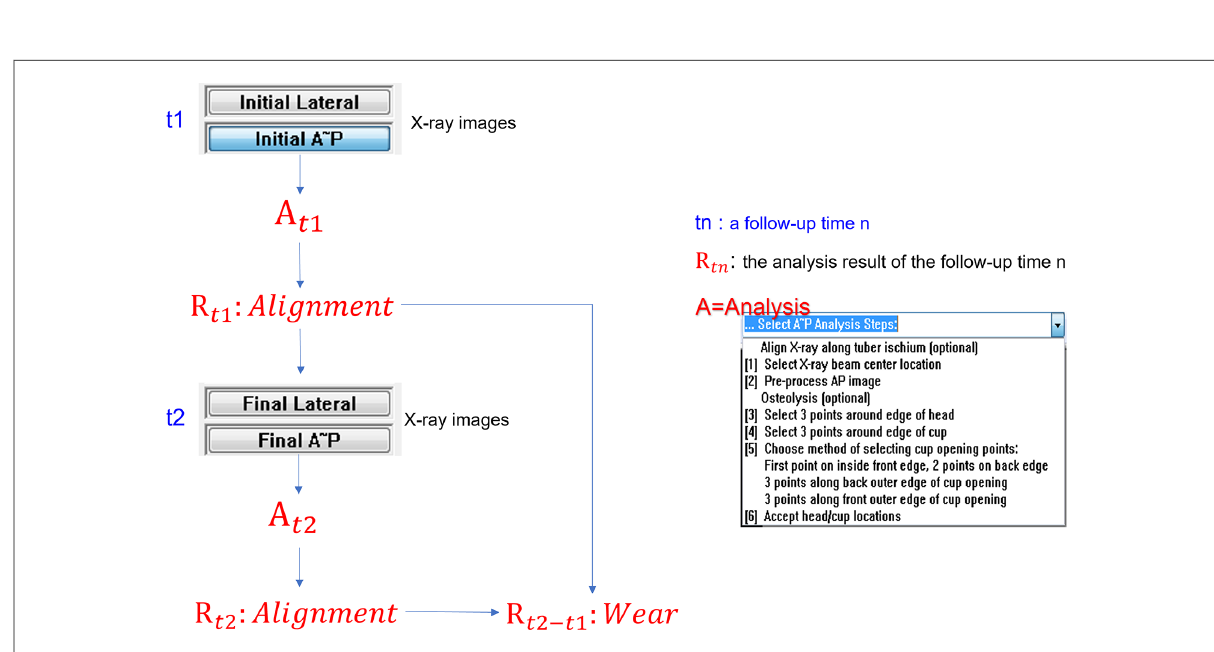
FIGURE 2 PolyWare measurement work fl